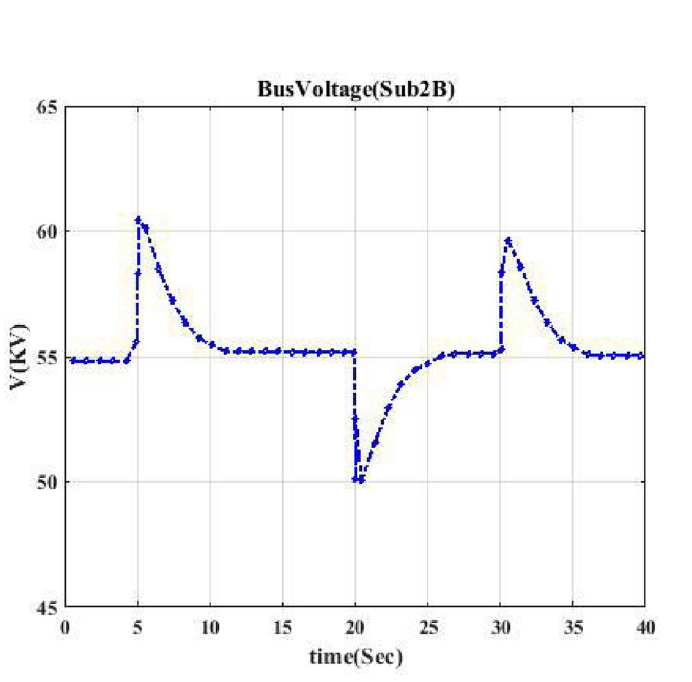
Fig 12. Voltage profile for switching the electric vehicle. This curve indicates the voltage curve when the electric vehicle is disconnected from the system.